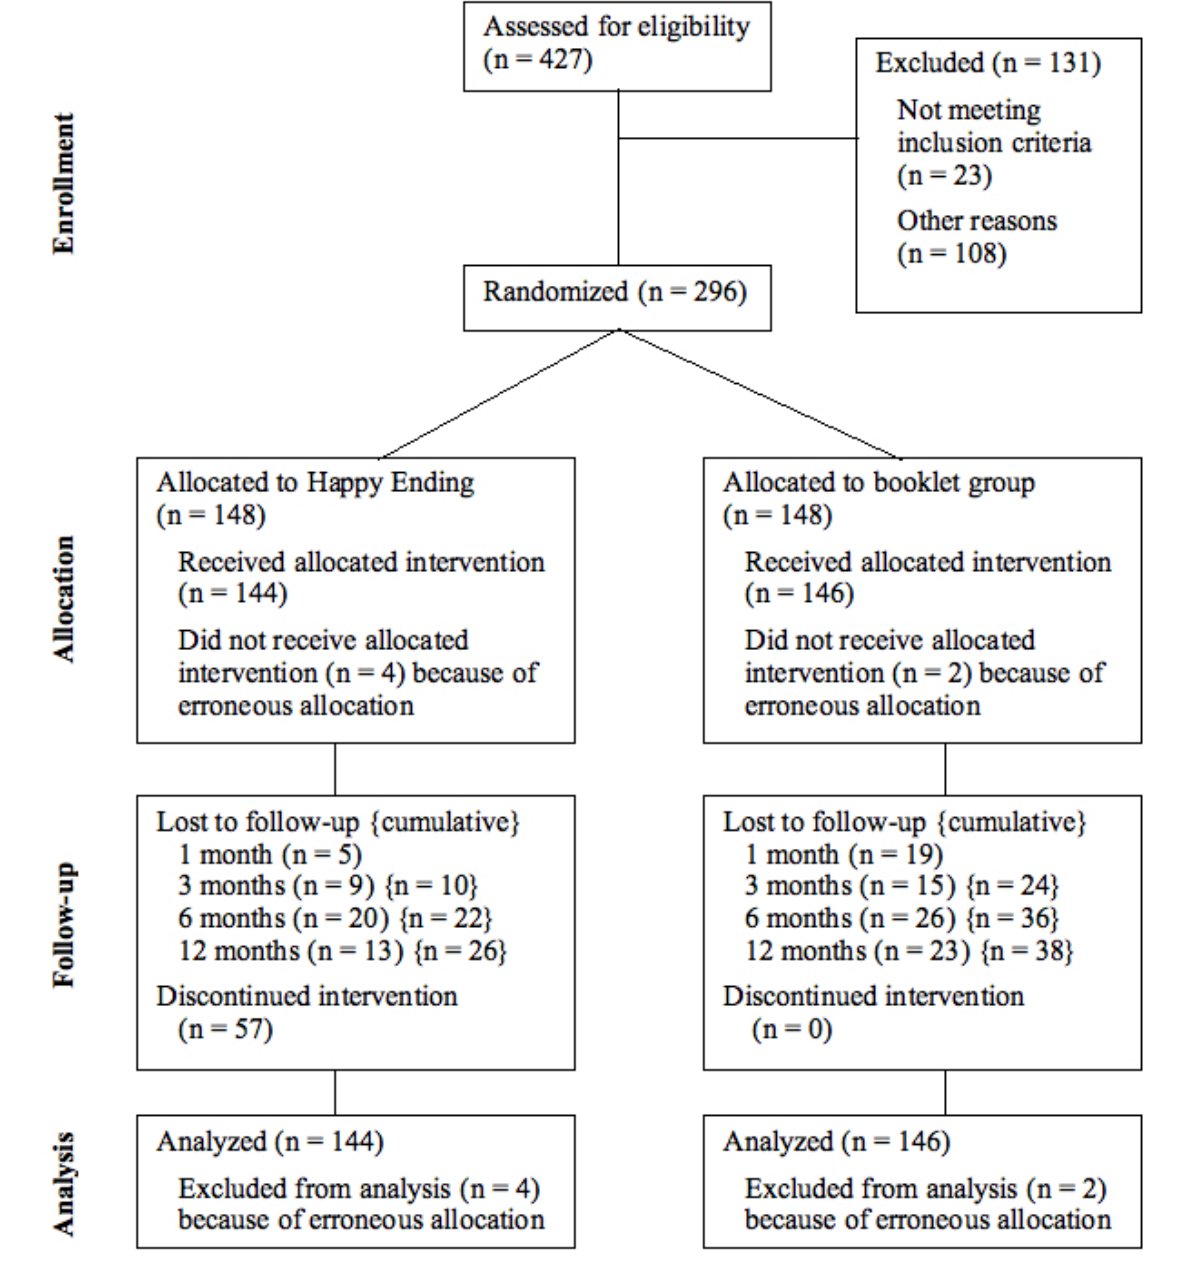
Figure 1. Flowchart of